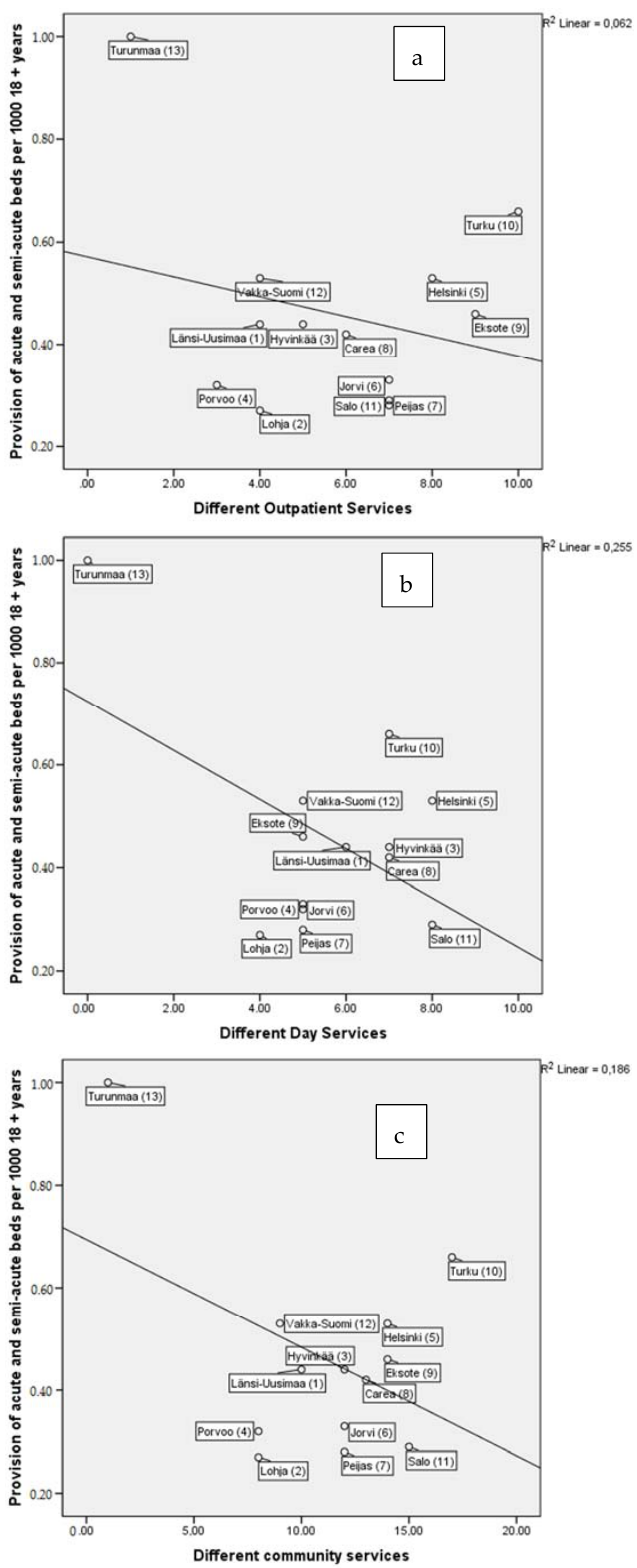
Figure 2. Association between acute- and semi-acute (time-limited) inpatient treatment provision and different; ( a ) outpatient-, ( b ) day care-, and ( c ) total community services- available. The numbers in brackets after catchment areas indicate the data collection order and were used in a previous article [20].